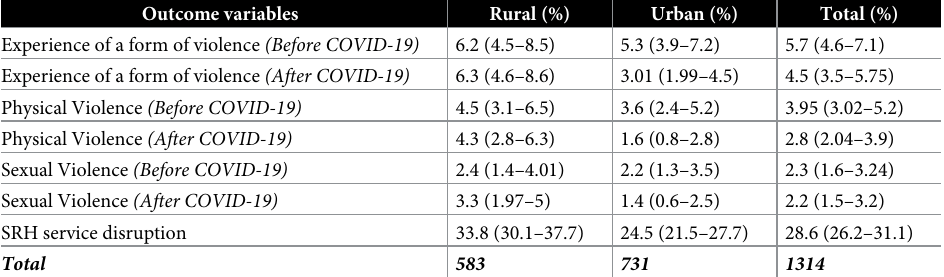
Table 3. Distribution of outcome variables by place of residence with 95% confidence interval.